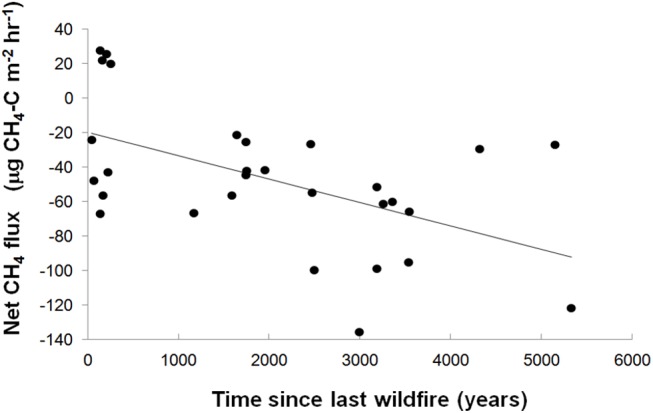
In situ CH4 flux versus time since last fire.
In situ 2006 CH4 chamber flux data versus time since last fire (R2 = 0.4; P = 0.001). Each data point represents the mean of five measurements made on each island at the same time. 10 depth measurements were made per island.